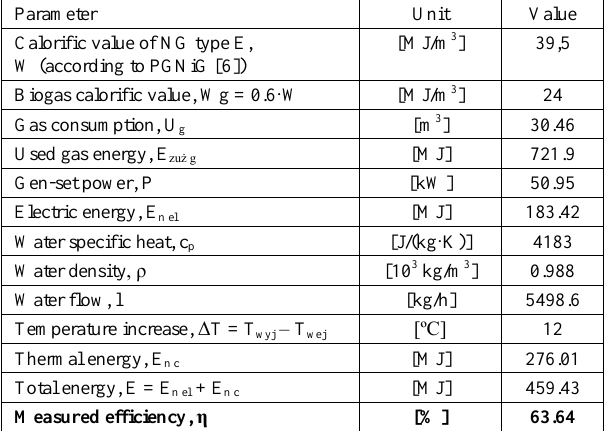
Fig. 5. Control panel during parameters reading. In the center, the main ComAp controller, below current water temperature readings at the heat exchangers. At the right – remote control module. Table 3. Basic parameters related with gen-set efficiency under load of 50